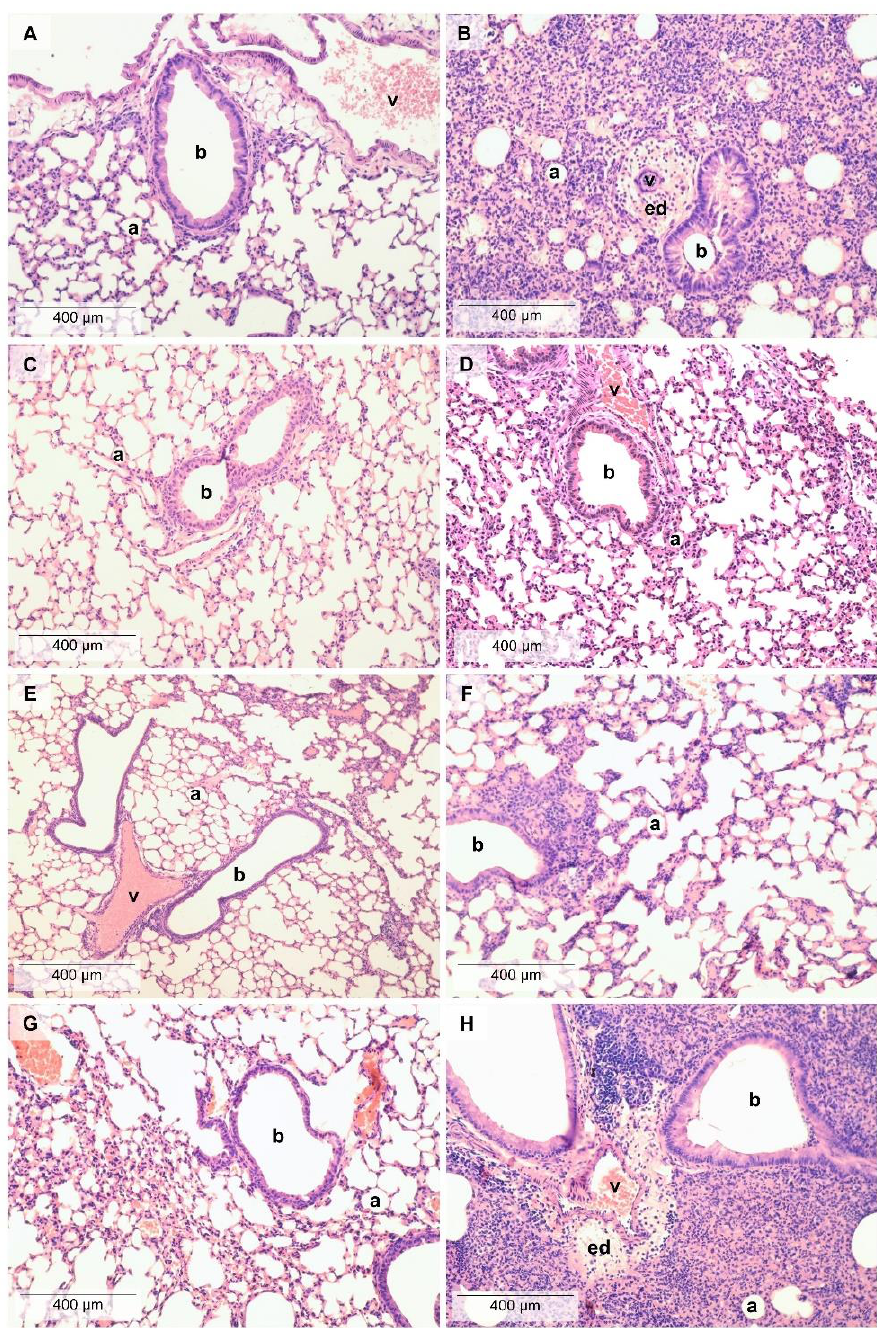
Figure 2. Histopathological alterations in the lung. Representative pictures of lung parenchyma after ( A ) PBS and PO treatment, ( B ) LPS and PO treatment, ( C ) PBS and TO treatment, ( D ) LPS and TO treatment, ( E ) PBS and CO treatment, ( F ) LPS and CO treatment, ( G ) PBS and LO treatment, and ( H ) LPS and LO treatment. (Hematoxylin–eosin staining, 200 × magnification; a: alveolus, b: bronchiole, v: vessel, ed: edema).